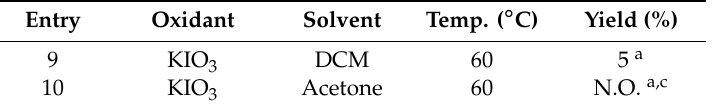
Table 2. Reaction scope of cyclization of the thiosemicarbazide.